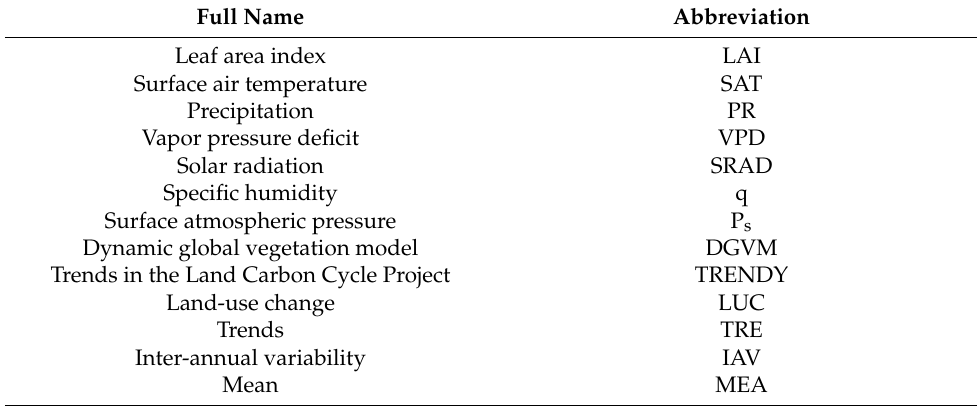
Table 2. Used abbreviations in this